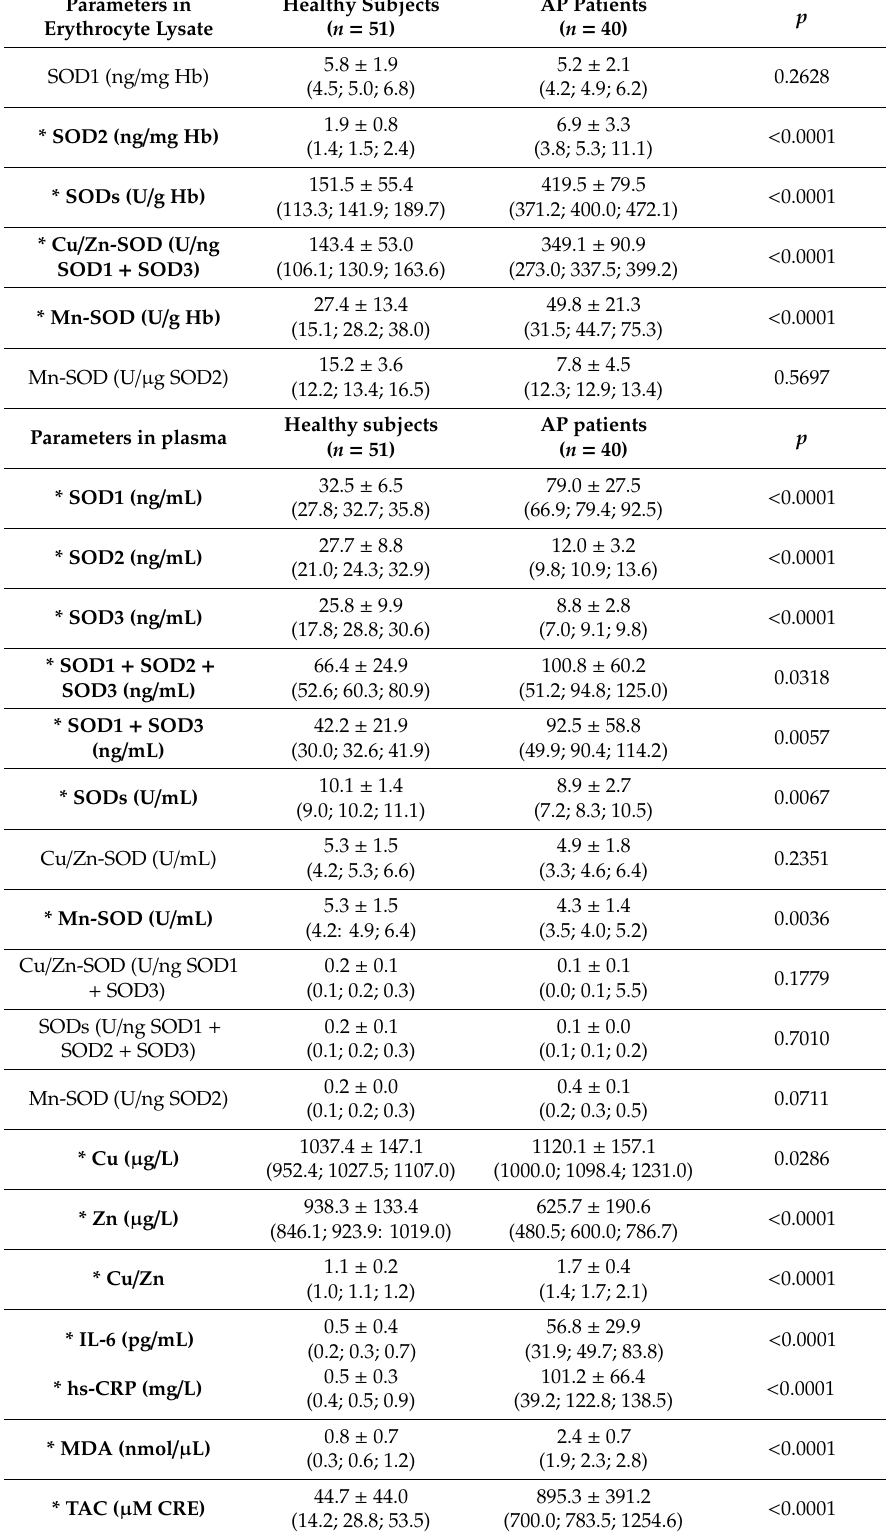
Table 3. The concentration and activities of SODs isoenzymes, the concentrations of metals (Cu, Zn), markers of inflammation and oxidative stress in the group of healthy subjects and AP